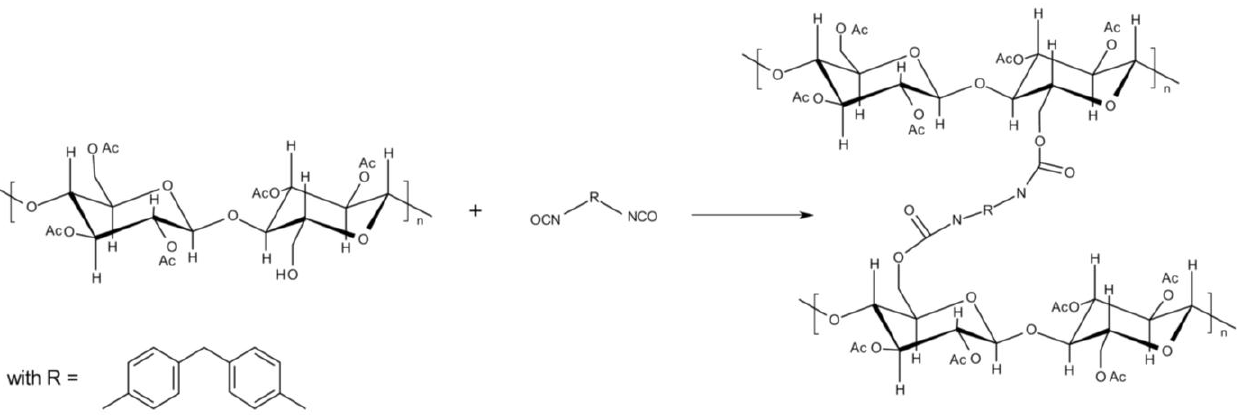
Figure 1. Scheme of isocyanate crosslinking of cellulose